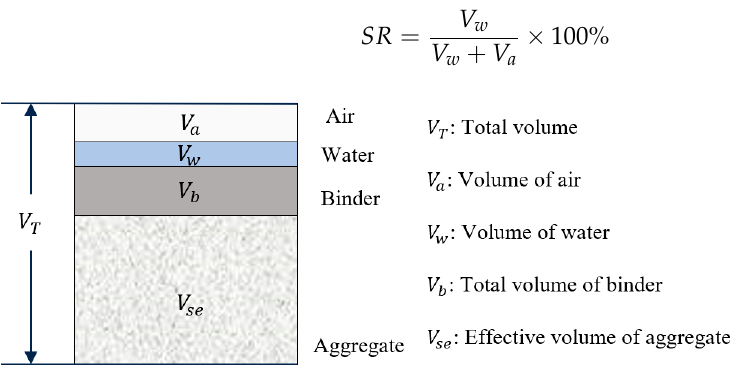
Figure 2. Composition and parameters of a non-dry asphalt mixture. Moisture content indicates the quantity of water contained in the AC mixture. It is defined as the ratio between the weights of water, W w , and the dry asphalt mixture, W dry . The relationship and its derivation between the moisture content, 𝑀𝐶 , and saturation ra- tio is shown in Equation (2).